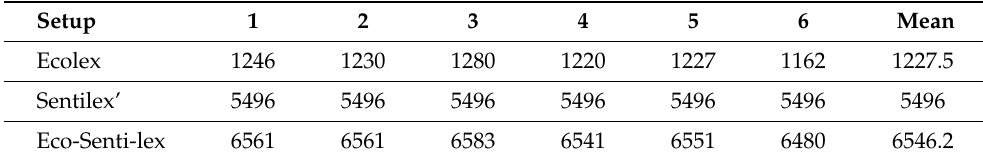
Table 9. Overview of lexicons used. Setup